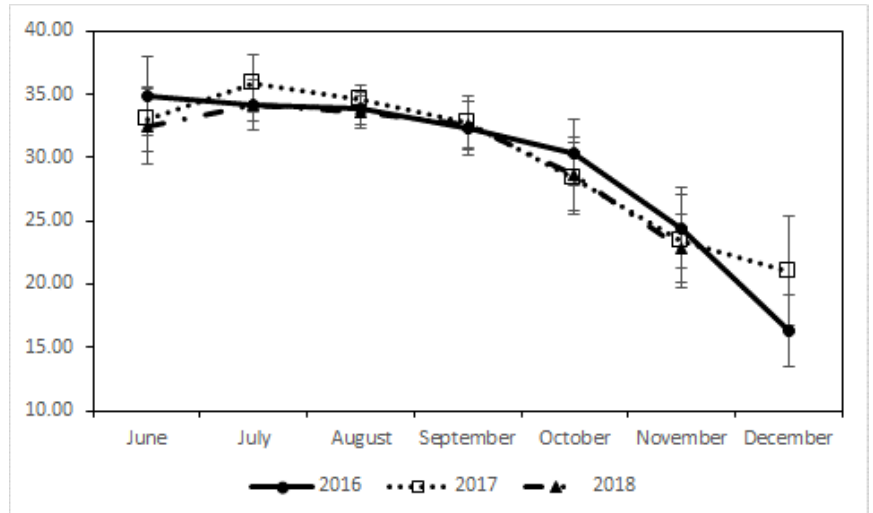
Figure A1. Monthly means ( ± SD) of the maximal daily temperatures at the field site over the 2016–2018 flowering seasons.